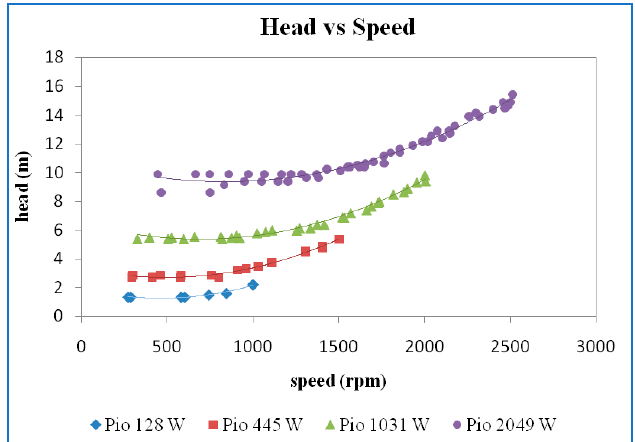
Figure 8. Head vs. speed at a guide vane opening of 10 mm.